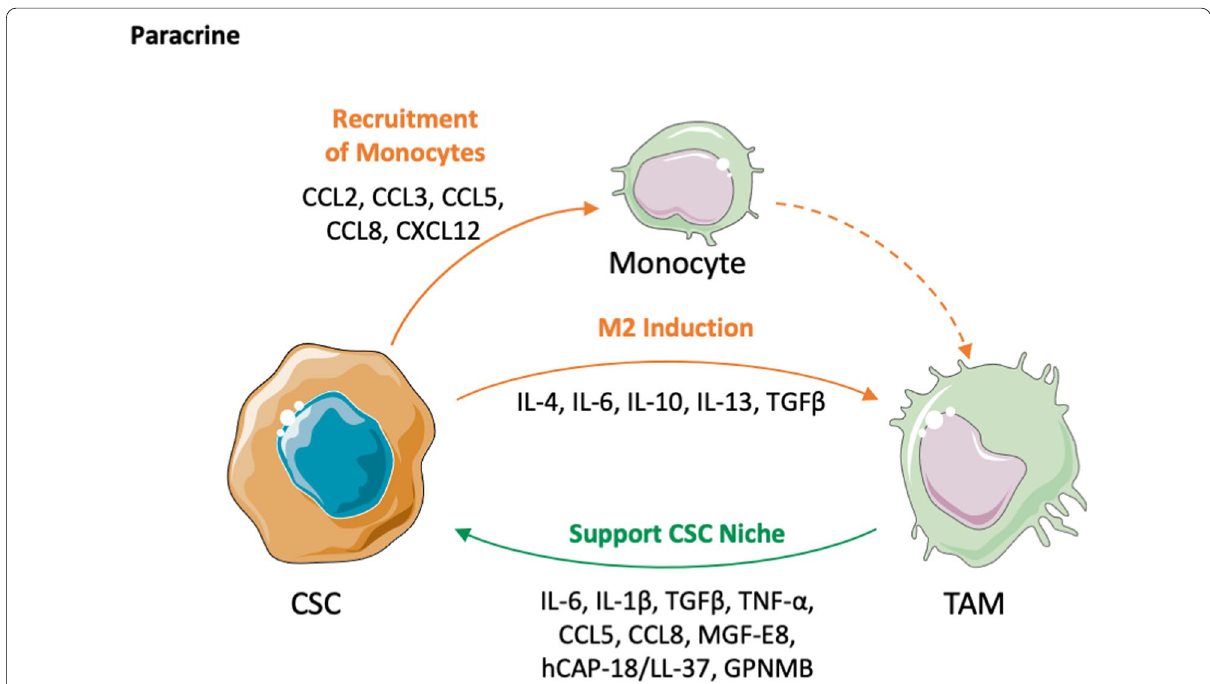
Fig. 1 Paracrine mechanisms of interaction between cancer stem cells (CSCs) and tumor-associated macrophages (TAM). CSCs produce chemotactic factors (CCL2, CCL3, CCL5, CCL8, CXCL12) to recruit circulating monocytes in the tumor; moreover, they shape macrophage polarization towards an M2-like, pro-tumoral, phenotype by secreting IL-4, IL-6, IL-10, IL-13, TGFβ. On the macrophage side, TAMs support CSCs and their niche by secreting IL-6, IL-1β, TGFβ, TNF-α, CCL5, CCL8, MGF-E8, hCAP-18/LL-37, GPNMB. This figure was made with Servier Medical Art templates, which are licensed under a Creative Commons Attribution 3.0. Unported License (https:// smart. servi er.